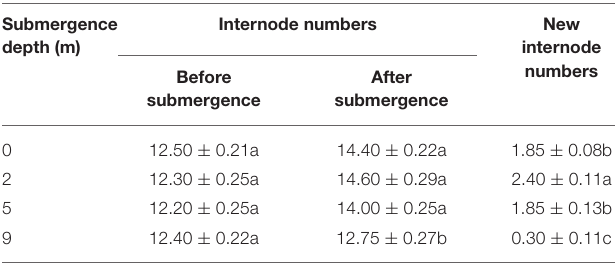
TABLE 2 | Internode numbers at the start and the end of treatments (means ± S.E. n =